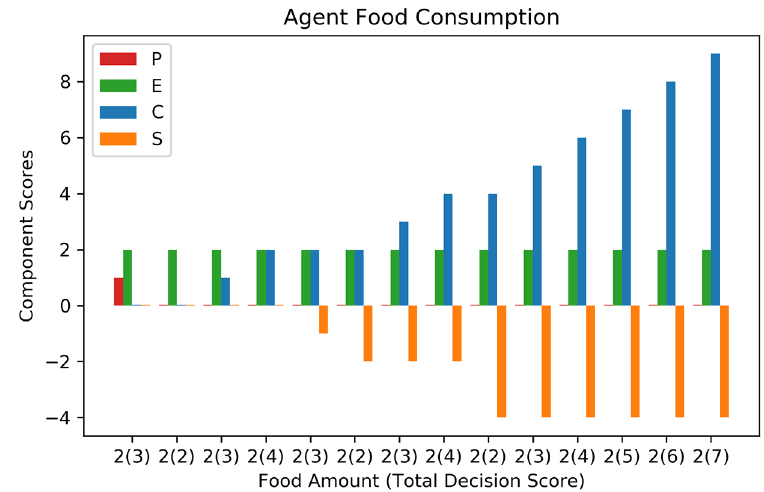
Figure 4. The food consumption history of an agent for 2 units of food with respective